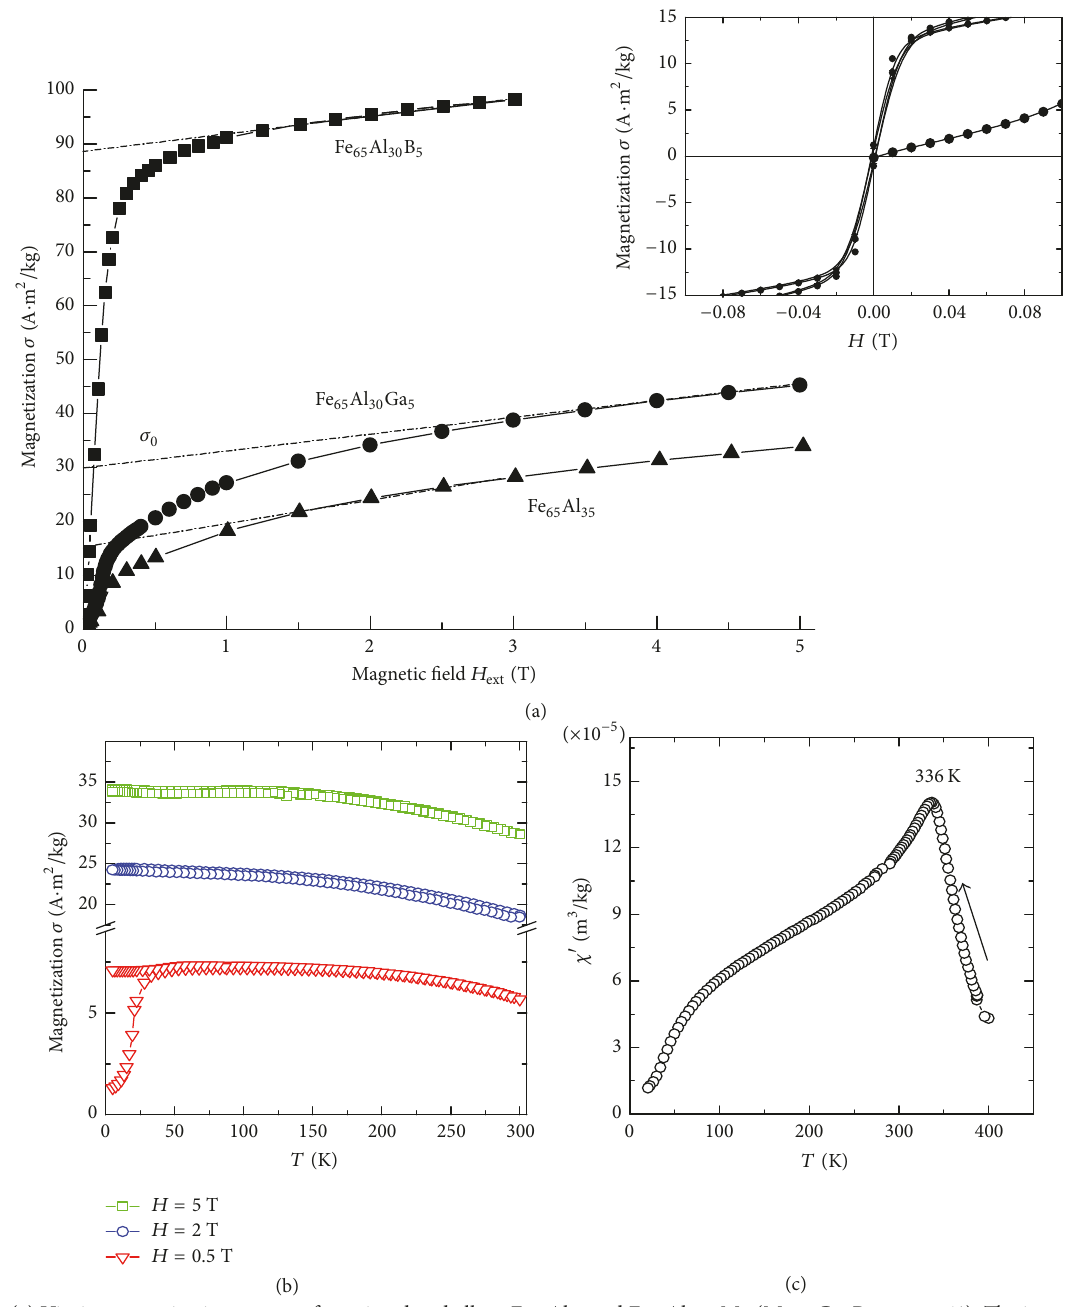
Figure 2: (a) Virgin magnetization curves of quasi-ordered alloys Fe 65 Al 35 and Fe 65 Al 35−𝑥 M 𝑥 (M 𝑥 = Ga, B; 𝑥 = 5 at.%). The inset: the virgin magnetization curve and the hysteresis loop for the alloy Fe 65 Al 30 Ga 5 ; (b) ZFC and FC cycles for Fe 65 Al 30 Ga 5 alloy at 𝐻 ext = 0.5, 2, 5 T; (c) the real part of AC susceptibility of the alloy Fe 65 Al 35